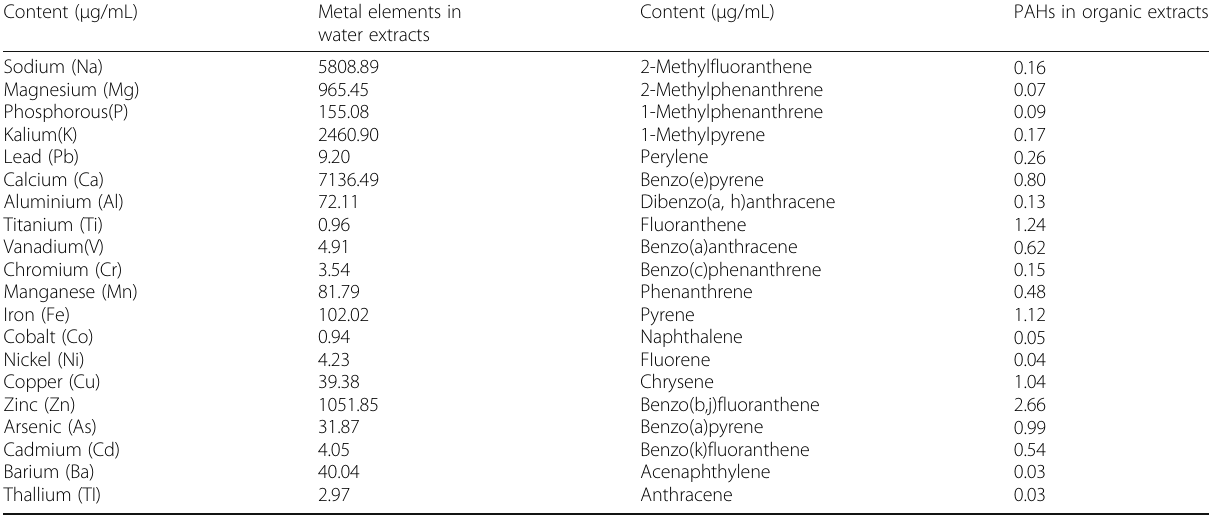
Table 2 Concentrations of elements in water and PAHs in organic extracts both at levels of 100 μ g/mL Content ( μ g/mL)